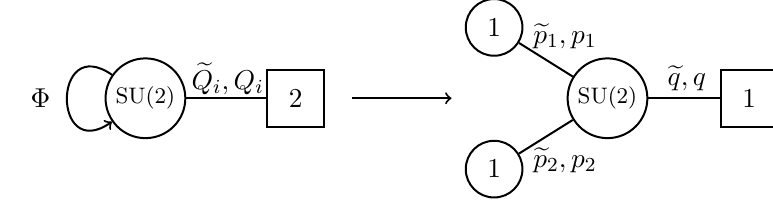
Figure 10. SU(2) adjoint SQCD with two (cid:13)avors and its mirror